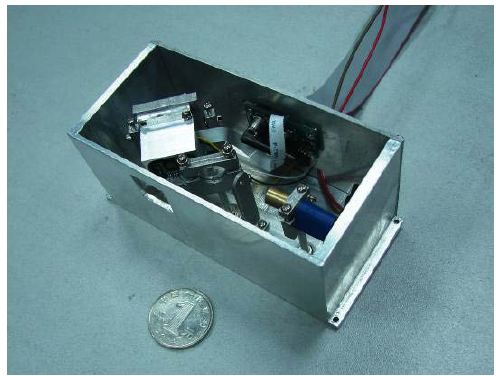
Figure 13. Prototype of MOEMS target